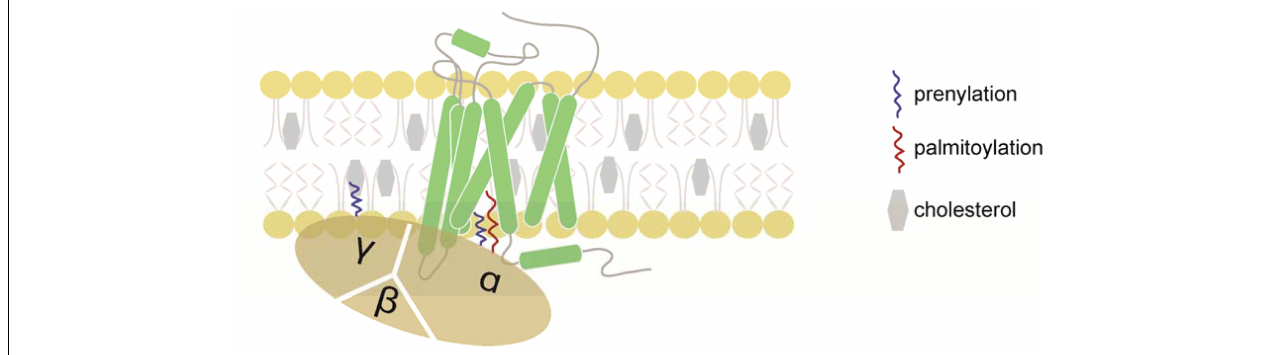
FIGURE 1 | Schematic representation of a chemokine receptor and its associated heterotrimeric G-protein. Chemokine receptors belong to the GPCR family and possess seven-transmembrane domains. Chemokines initiate chemokine receptor activation by binding to the N-terminus and extracellular loops of the receptor. Once the chemokine is tethered to the receptor, the N-terminus enters the binding pocket where it interacts with the transmembrane domains of the chemokine receptor. The presence of cholesterol is critical for the stability of the chemokine receptor. Upon ligand binding, the receptor promotes the exchange of GDP for GTP on the G α -subunit, resulting in the dissociation of the G α - from the G βγ -subunits and downstream signaling. The G α - and G γ -subunits are post-transcriptionally lipidated facilitating their association with the plasma